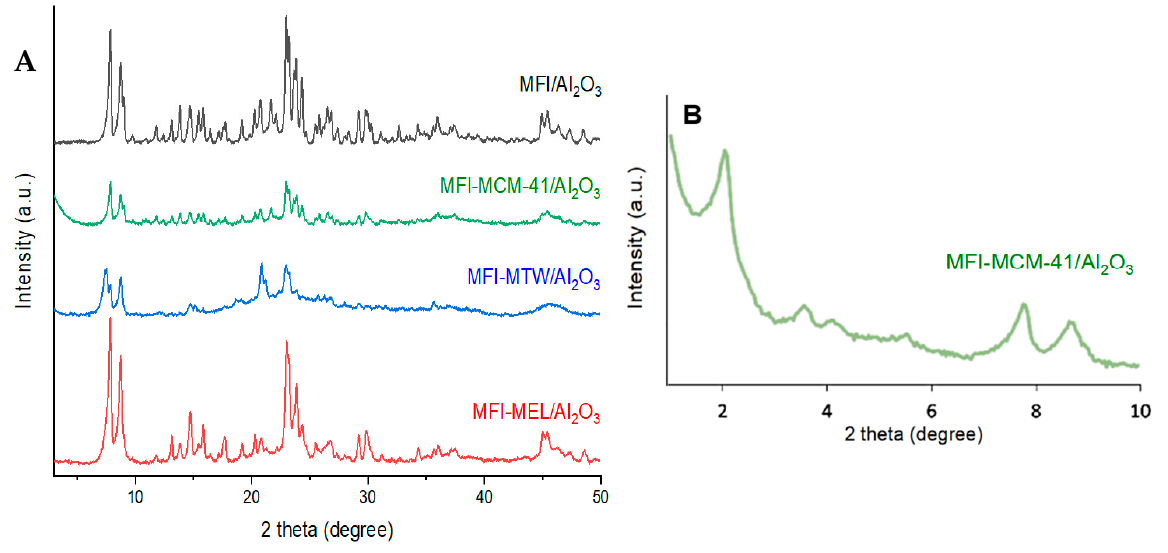
Figure 1. XRD patterns of the catalysts. ( A ) WAXRD-patterns; ( B ) SAXRD-pattern of MFI-MCM- 41/Al 2 O 3 .